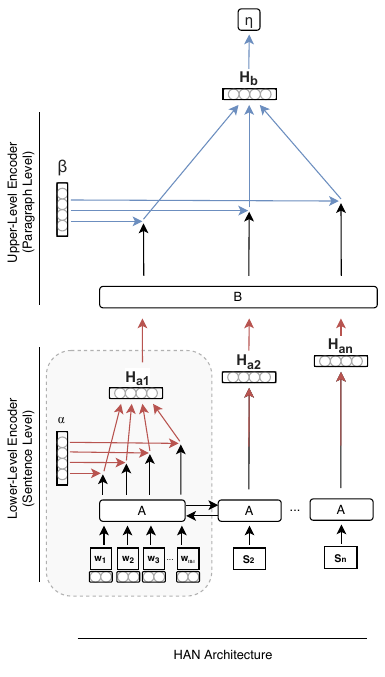
Figure 2. Hierarchical Attention Network (HAN)